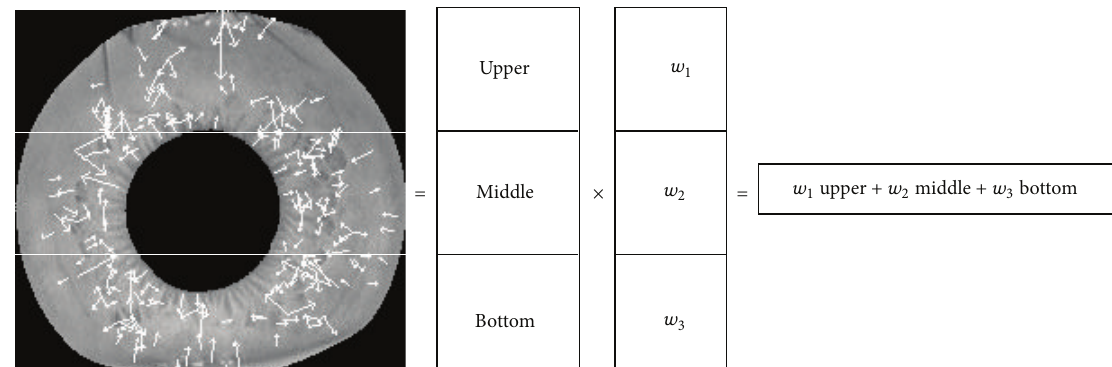
Figure 12: The process of weighted matching.